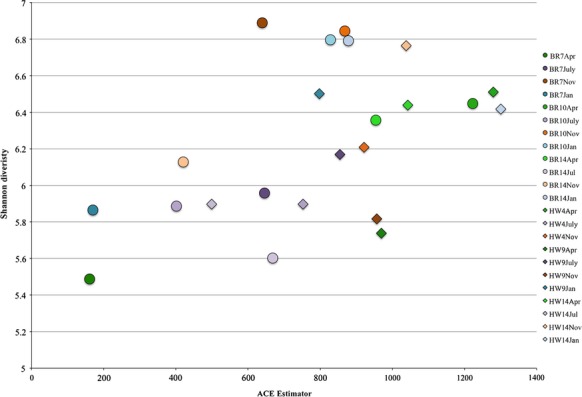
Shannon and abundance-based coverage estimation (ACE) diversity plot. Each seawater community appears similarly diverse. The average diversity for each site was taken. According to the abundance coverage estimator, certain samples (BR7Apr, BR7Jan, and BR10July) show lower richness despite being equally diverse. Fewer operational taxonomic units (OTUs) (<2000) were observed for these samples. BR7Nov, BR10Jan, BR10Nov, and BR14July showed the most Shannon diversity despite modest ACE values.